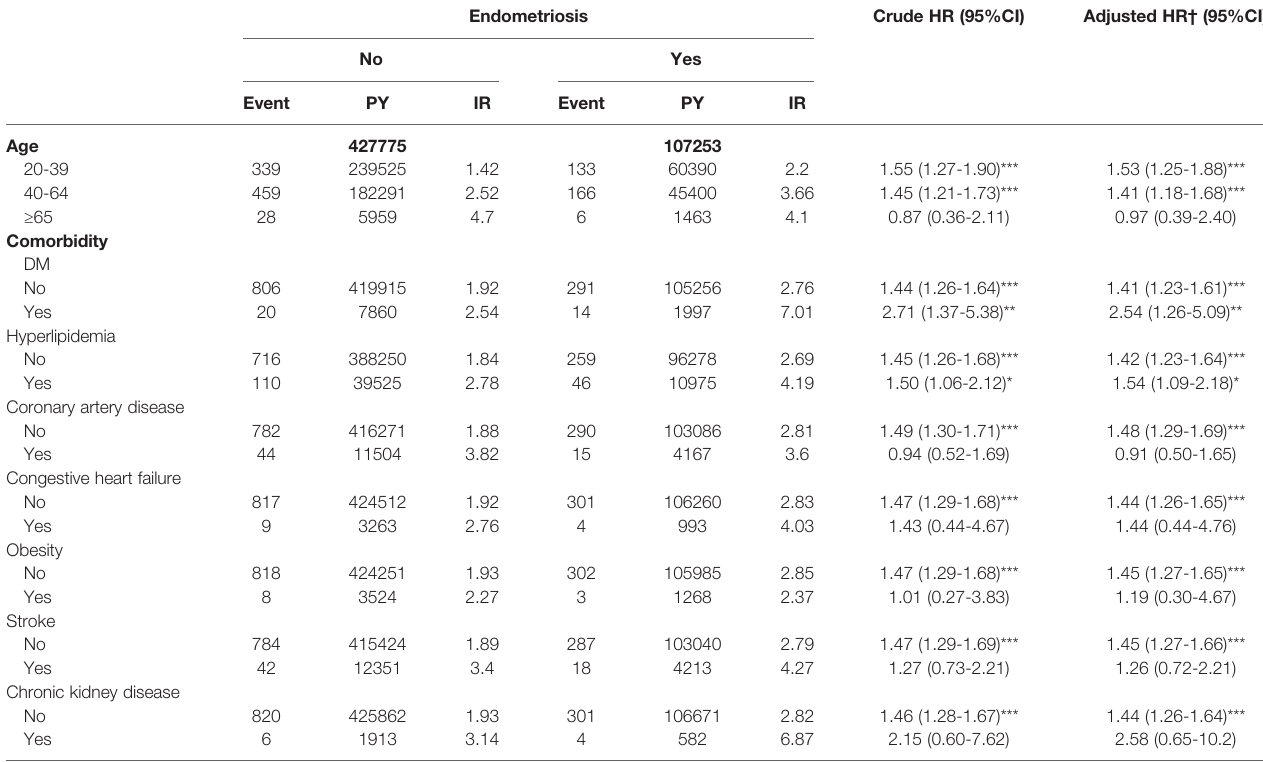
TABLE 3 | Cox regression analyses of Sjögren ’ s syndrome in patients with endometriosis strati fi ed by age and